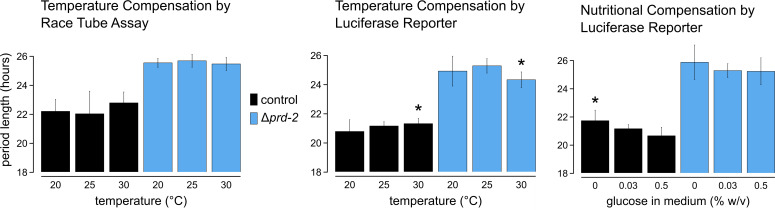
Temperature and nutritional compensation are normal in ΔNCU01019.Temperature and nutritional compensation were assessed in ras-1bd controls compared to ras-1bd Δprd-2. Race tubes (RTs) were incubated at 20°, 25°, or 30°C to determine free running period length. Temperature did not significantly affect period length for controls (ANOVA p=0.598) or for the Δprd-2 mutant (ANOVA p=0.756) RTs. 96-well plates were incubated at 20°, 25°, or 30°C to determine free running period length. Period was significantly different at 30°C for both genotypes (Asterisks [*]: control 20°C vs 30°C, Tukey test p=0.023; Δprd-2 20°C vs 30°C, Tukey test p=0.037; Δprd-2 25°C vs 30°C, Tukey test p=0.0002). 96-well plates were run with 0%, 0.03%, or 0.5% glucose w/v to test nutritional compensation. Period length was significantly different at 0% glucose for controls only (Asterisk [*]: control 0% vs 0.5%, Tukey test p=0.00005; control 0% vs 0.03%, Tukey test p=0.034; Δprd-2 ANOVA p=0.183).